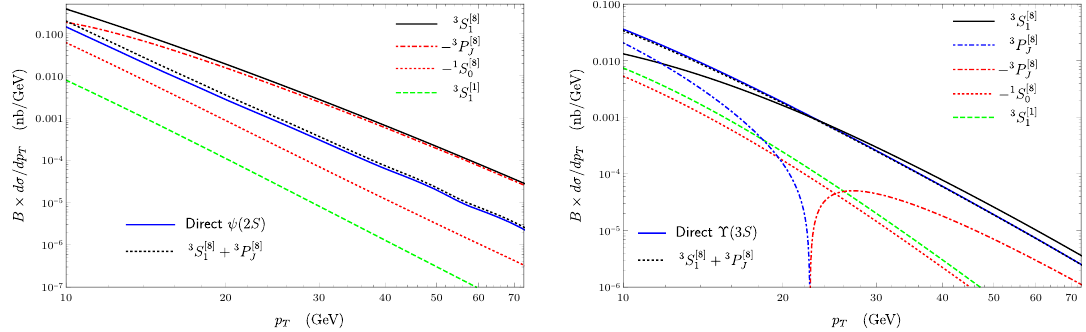
Figure 8 . Contributions from individual channels to the direct production rate of 3 S 1 -wave charmonium (left) and bottomonium (right) at the LHC center of mass energy integrated over the rapidity range | y | < 1 . 2 , computed with the LDMEs determined from the fit with p T / (2 m ) > 3 . Here, B is the branching fraction into a muon pair. Absolute values of negative contributions are shown in red. We also show the sum of 3 S [8] lines), which make up for the bulk of the direct cross section (blue solid